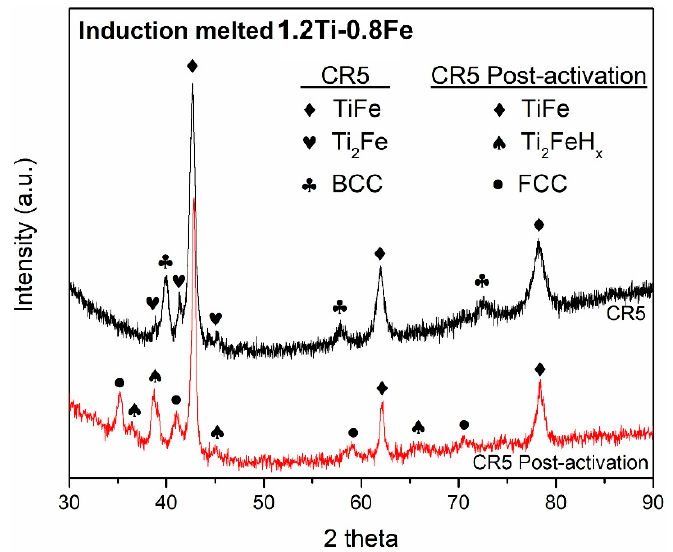
Figure 4. X-ray diffraction patterns of the cold-rolled-five-times (CR5) induction-melted 1.2Ti-0.8Fe alloys before and after activation.